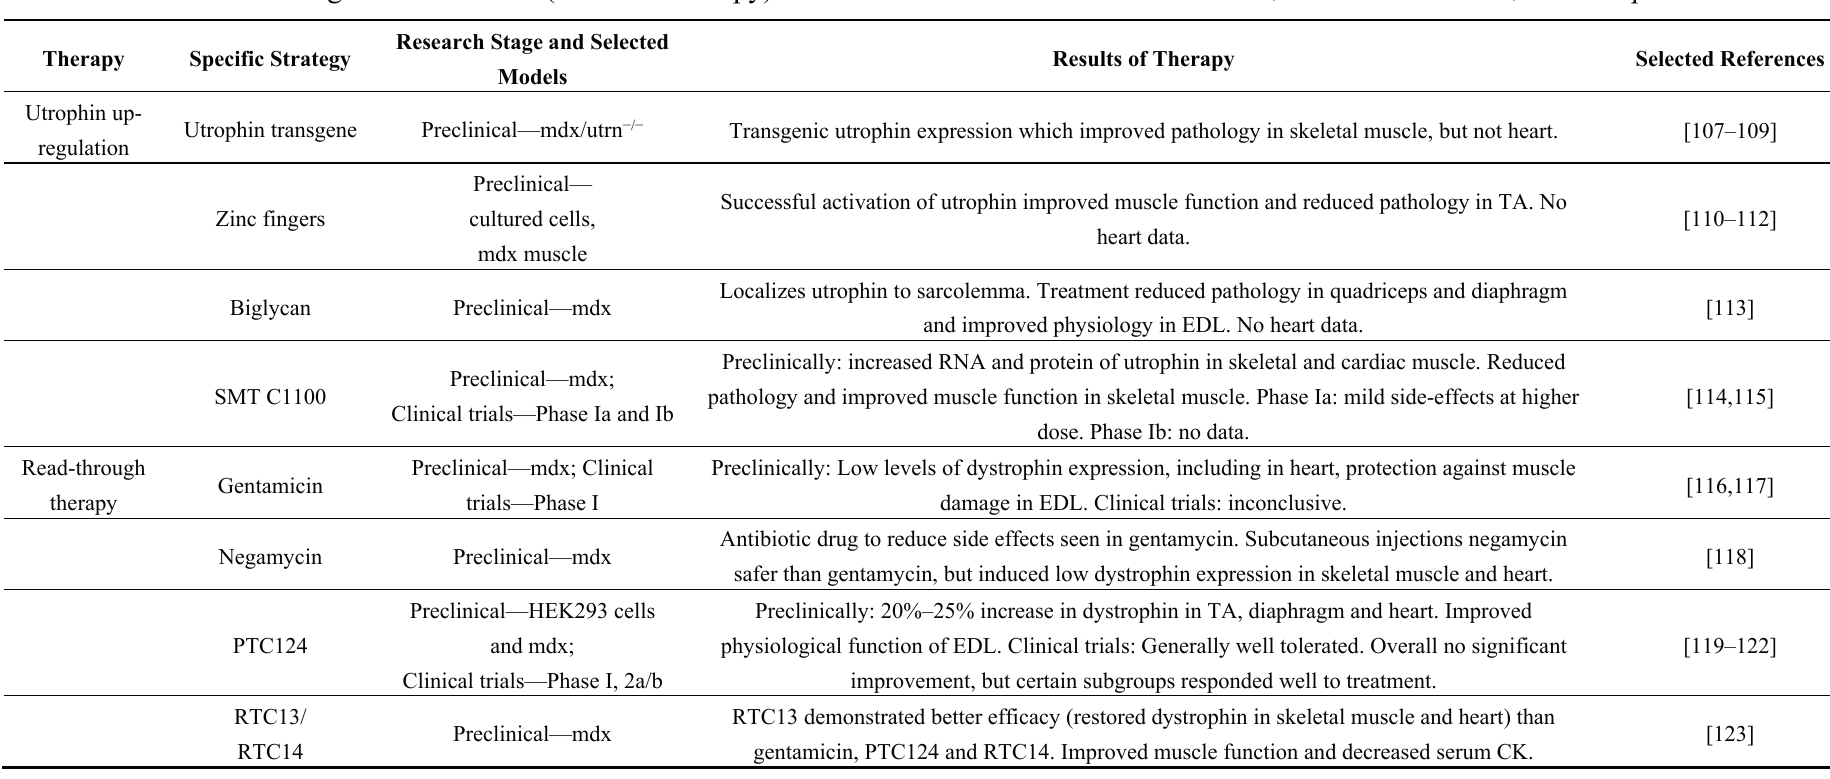
Table 1. DMD therapies under development. Several strategies have been employed to further develop the different types of therapies (specific strategy), which are in different stages of research, either clinical or pre-clinical (research stage and selected models). A brief summary of the results of these strategies is mentioned (results of therapy) with selected references. IV: Intravenous; IM: intramuscular; IP: intraperitoneal